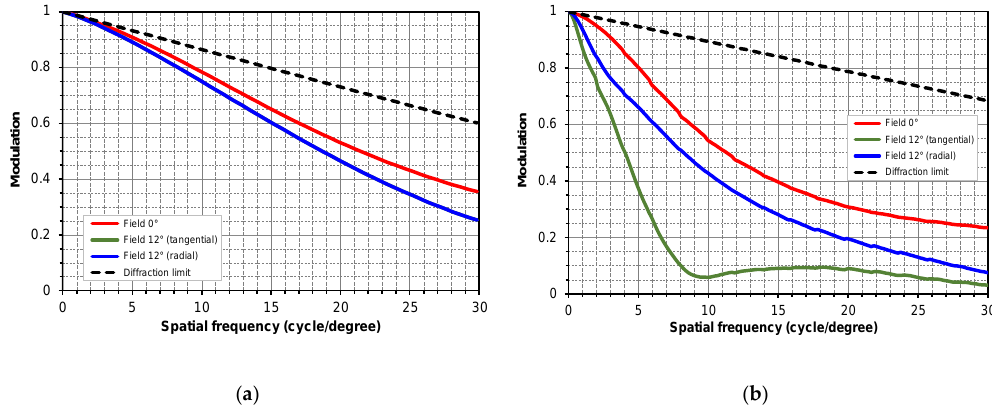
Figure 10. Calculated MTFs of ( a ) real and ( b ) virtual images. At the spatial frequency of 30 cycle / degree, MTFs for all fields of the real and virtual images are above 0.252 and 0.032, respectively.